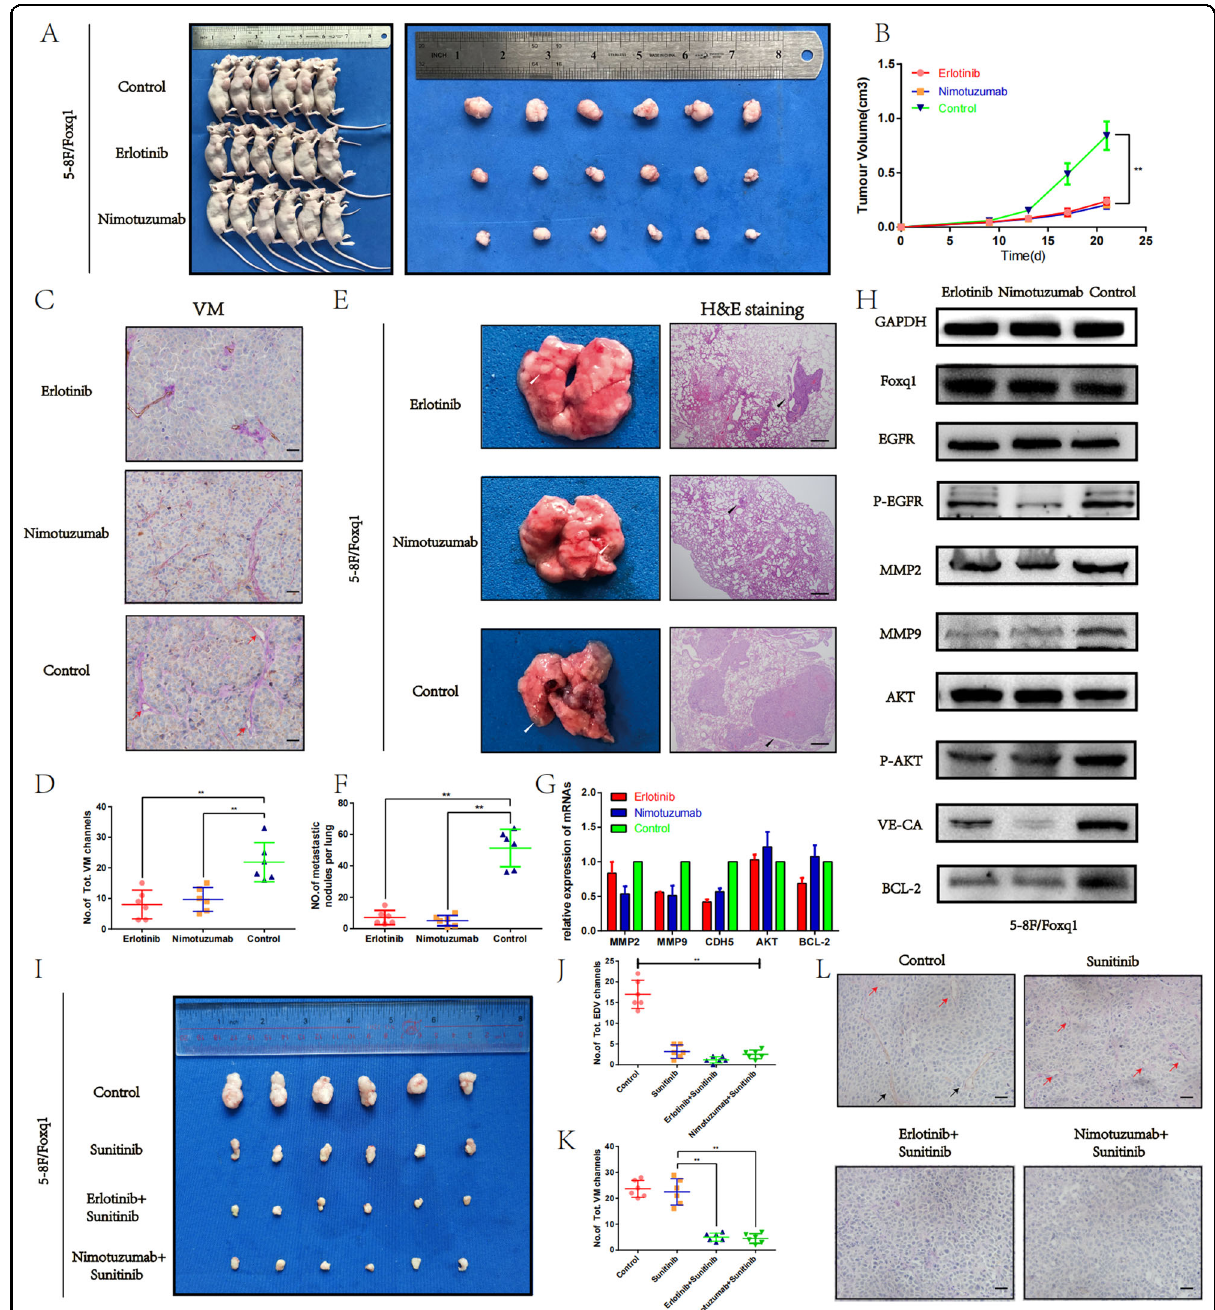
Fig. 6 Erlotinib and Nimotuzumab could inhibit Foxq1-induced VM formation and NPC growth and metastasis in vivo. A Image of xenograft tumors from nude mice injected with Foxq1 overexpressing 5 – 8F cells, that were treated with Erlotinib (i.g,50 mg/kg), Nimotuzumab (i.v,20 mg/kg), or physiological saline, respectively. B The growth curves of the xenograft tumors from each group; p < 0.001. C PAS/CD31 staining of xenograft tumors from each group; Scale bars represent 50 μ m. D Statistical results of VM channels in xenograft tumors from each group; p < 0.001. E Metastatic nodules in each group following tail vein injection (left). Image of H&E staining of lung sections from each group (right); Scale bars represent 500 μ m. F Statistical results of metastatic nodules of each group; p < 0.001. The expression of related genes in xenograft tumors from each group were monitored by qRT-PCR ( G ) and western blot ( H ). I Image of xenograft tumors from nude mice injected with Foxq1 overexpressing 5 – 8F cells, that were treated with Sunitinib (i.g., 40 mg/kg), Sunitinib (i.g., 40 mg/kg) + Erlotinib (i.g., 50 mg/kg), Sunitinib (i.g., 40 mg/kg) + Nimotuzumab (i.v., 20 mg/ kg), or physiological saline, respectively. J Statistical results of EDV channels in xenograft tumors from each group; p < 0.001. K Statistical results of VM channels in xenograft tumors from each group; p < 0.001. L PAS/CD31 staining of xenograft tumors from each group; Scale bars represent 50 μ m. Data are presented as mean ± SD of three independent